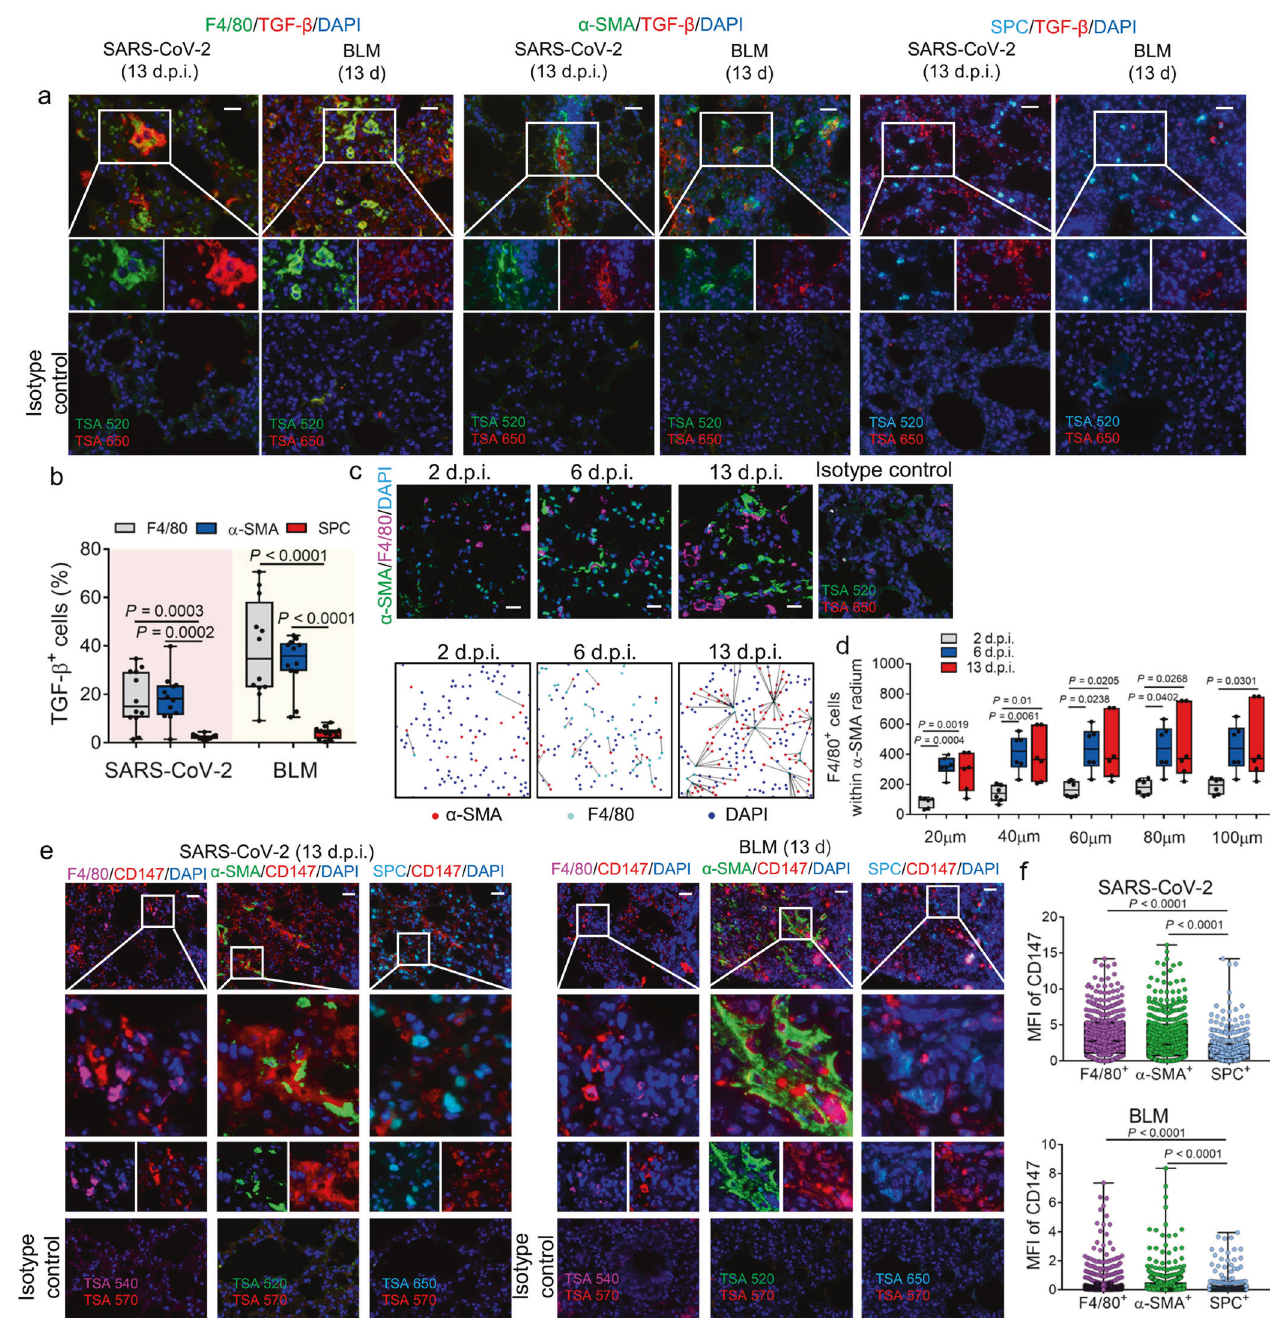
Fig. 3 Activation of TGF- β -CD147 axis in fi broblasts in lungs of SARS-CoV-2-infected hCD147 mouse model. a Multiplex immunohistochem- istry of lung tissue sections for F4/80, α -SMA, SPC and TGF- β from SARS-CoV-2-infected hCD147 mice at 13 d.p.i. and bleomycin-induced pulmonary fi brosis model at 13 days post-bleomycin administration. Scale bars, 50 μ m. b Statistics of the percentages of cells expressing TGF- β in cells positive for F4/80, α -SMA or SFTPC (SPC). n = 12 images from three mice for each group, one-way ANOVA followed by multiple comparisons. c Representative multiplex immunohistochemistry staining of lung tissue sections from SARS-CoV-2-infected hCD147 mice for F4/80 and α -SMA from 2 to 13 d.p.i. Scale bars, 25 μ m. d The number of F4/80 + macrophages within the 100 μ m radium of α -SMA + fi broblasts. n = 6 images (100 ×) from 3 mice for each group, one-way ANOVA followed by multiple comparisons. e Multiplex immunohistochemistry of lung tissue sections for CD147, F4/80, α -SMA and SPC from SARS-CoV-2-infected hCD147 mice at 13 d.p.i. and bleomycin-induced pulmonary fi brosis model at 13 days post-bleomycin administration. For samples from SARS-Cov2-infected hCD147 mice and bleomycin-treated C57BL/6J mice, anti-human CD147 antibody and anti-mouse CD147 antibody were used respectively. Scale bars, 50 μ m. f Quanti fi cation of the mean fl uorescence intensity (MFI) of CD147 in cells positive for F4/80, α -SMA or SPC. One-way ANOVA followed by multiple comparisons. In a , c and e , the rabbit or mouse IgG isotype control was used along with the staining of each molecule